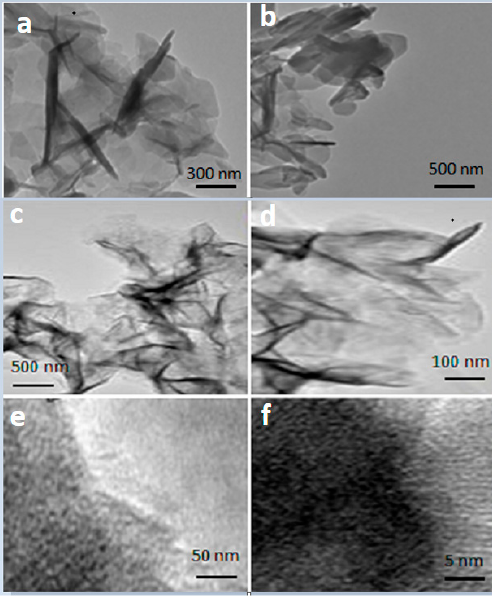
Figure 4. TEM images for pure Al 2 O 3 at 300 nm ( a ), 500 nm ( b ), and for 16%-CuO/ γ -Al 2 O 3 materials at 500 nm ( c ), 100 nm ( d ), 50 nm ( e ) and 5 nm ( f ).